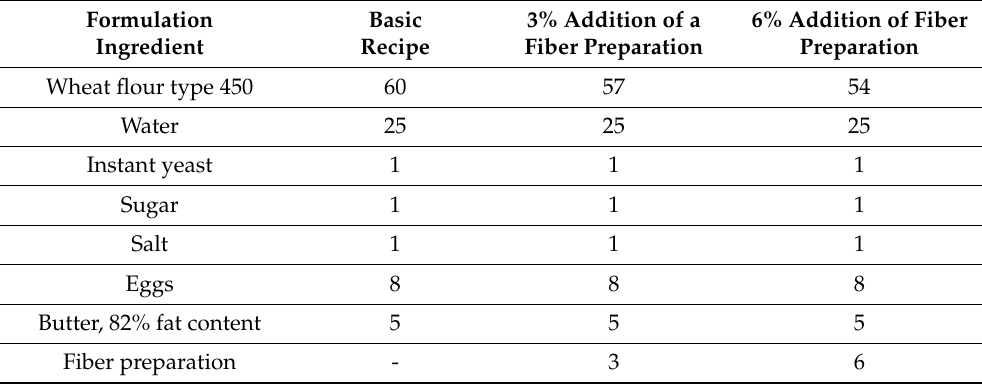
Table 2. Composition of recipe (%) of wheat dough in the form of rolls enriched with studied fiber